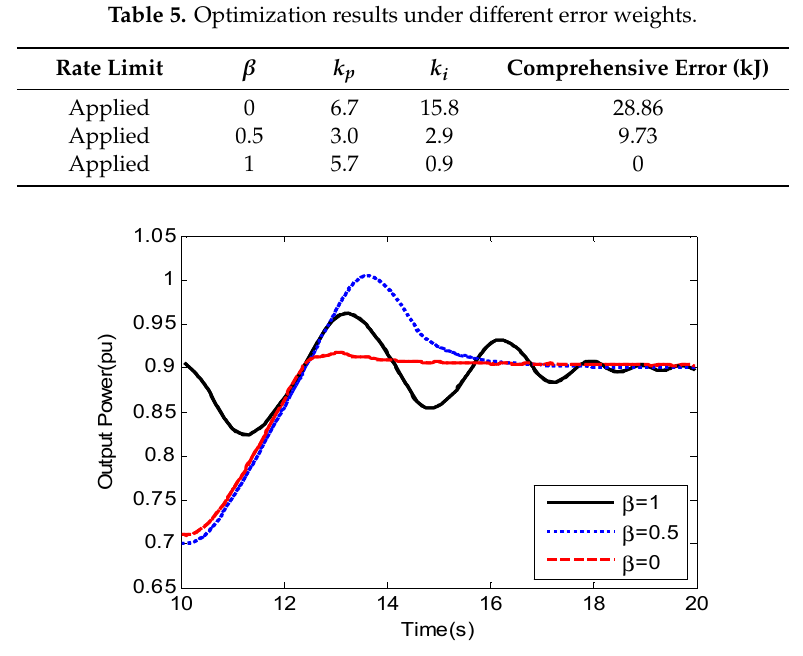
ff erent error Figure 13. Power response of different error weights. Figure 13. Power response of di Figure 13. Power response of different error weights.